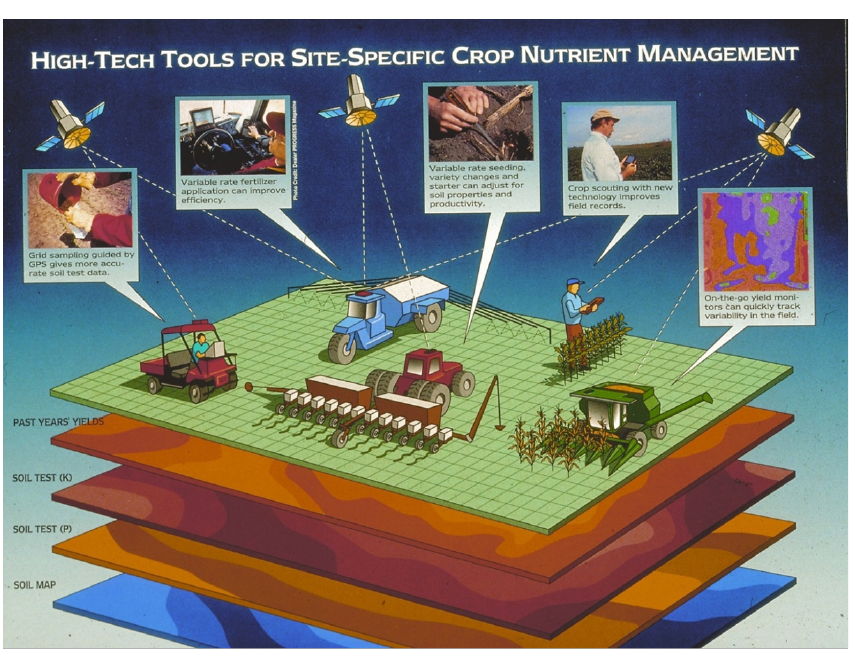
Fig. 2. A mid-1990s view of precision farming from the CCNetAg group (Sonka and Coaldrake,